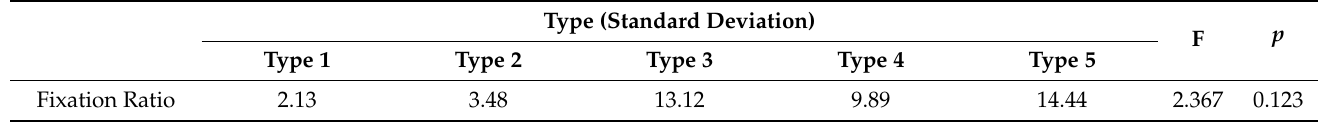
Table 30. Homogeneity of variance analysis for the proportion of key fixation points of different sizes. Type (Standard Deviation)